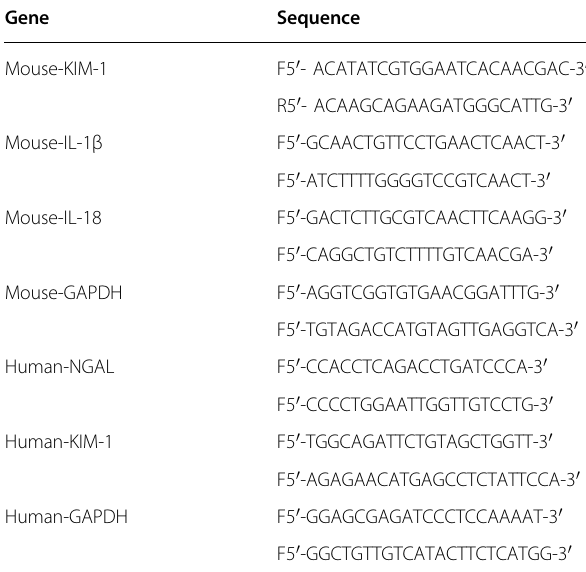
Table 1 Primer sequences for